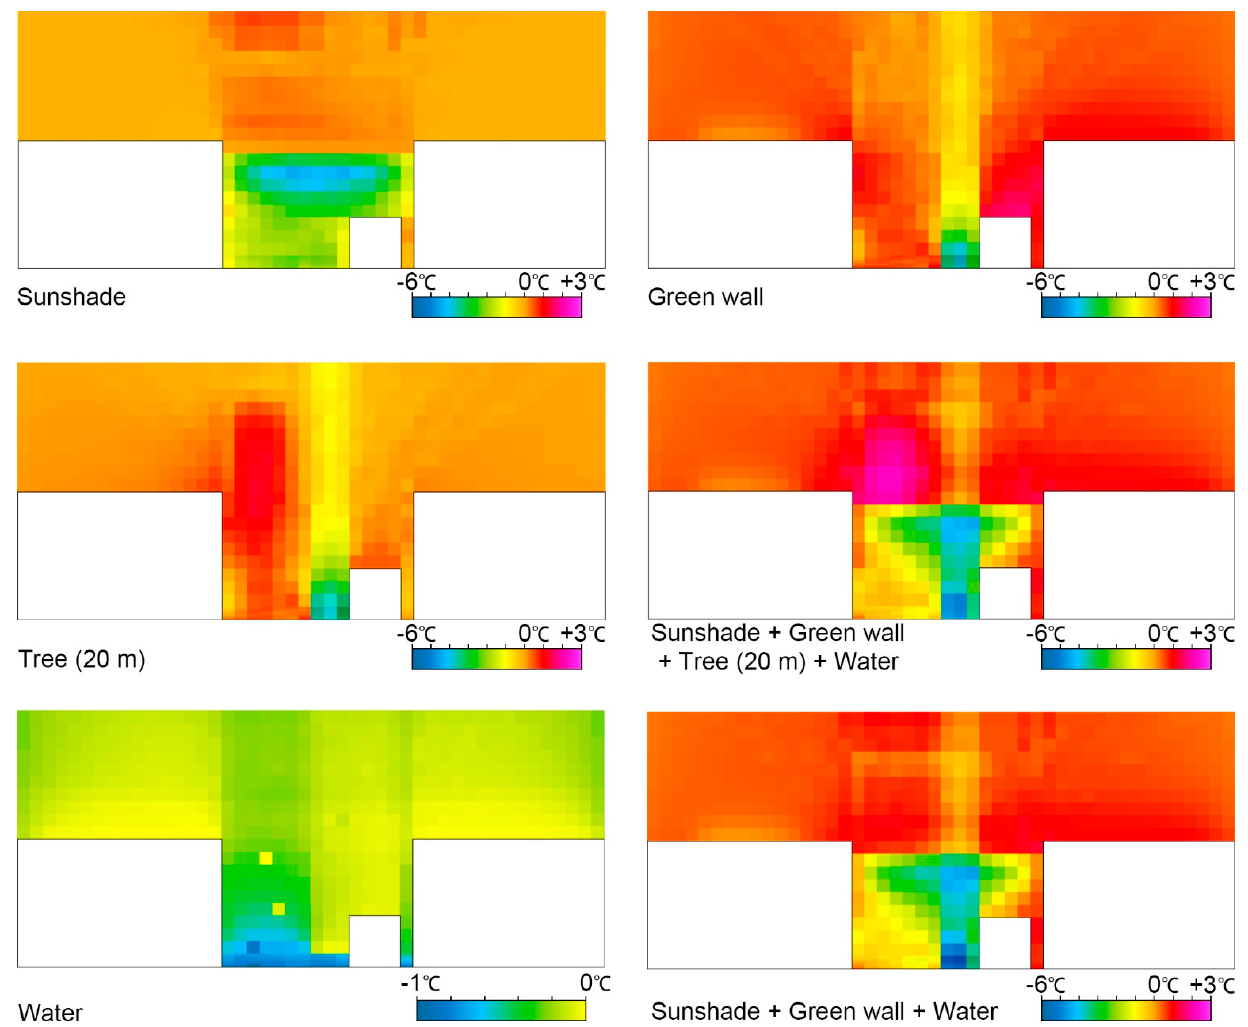
Figure 7. ENVI-met simulation results of improved designs for PET.